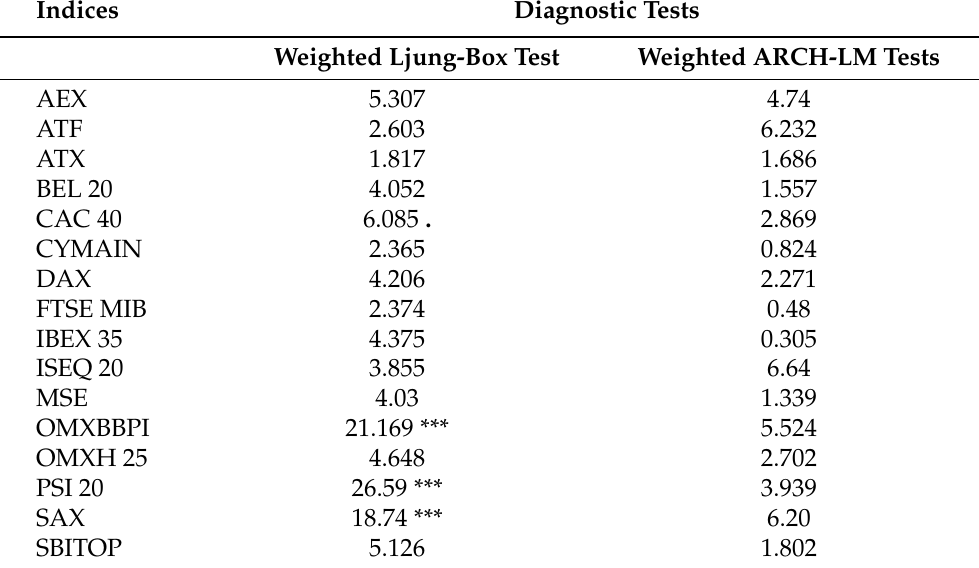
Table A4. Diagnostic Tests